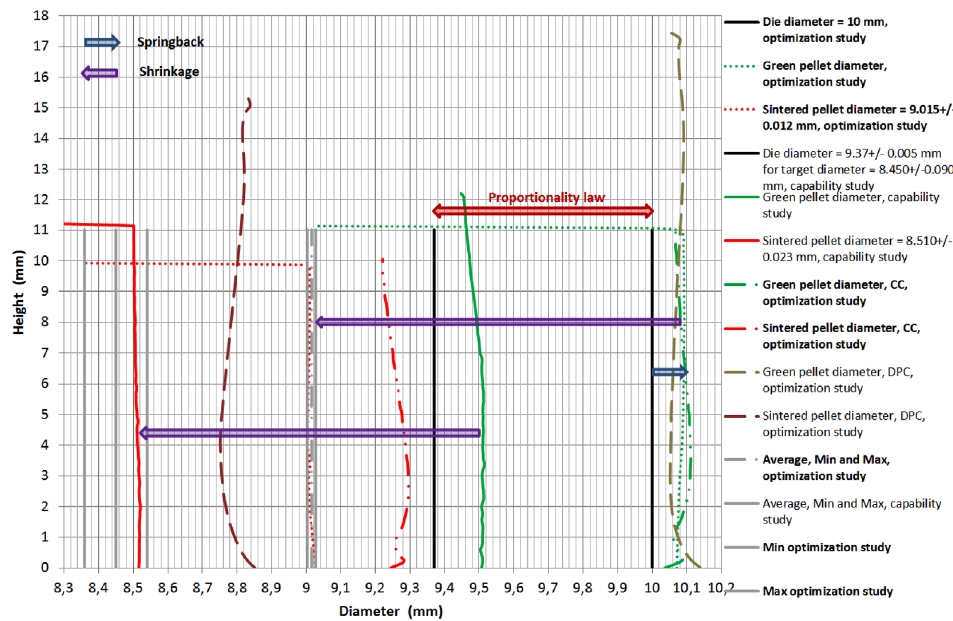
Fig. 5. Comparison between optimization and capability studies, experimental and calculated